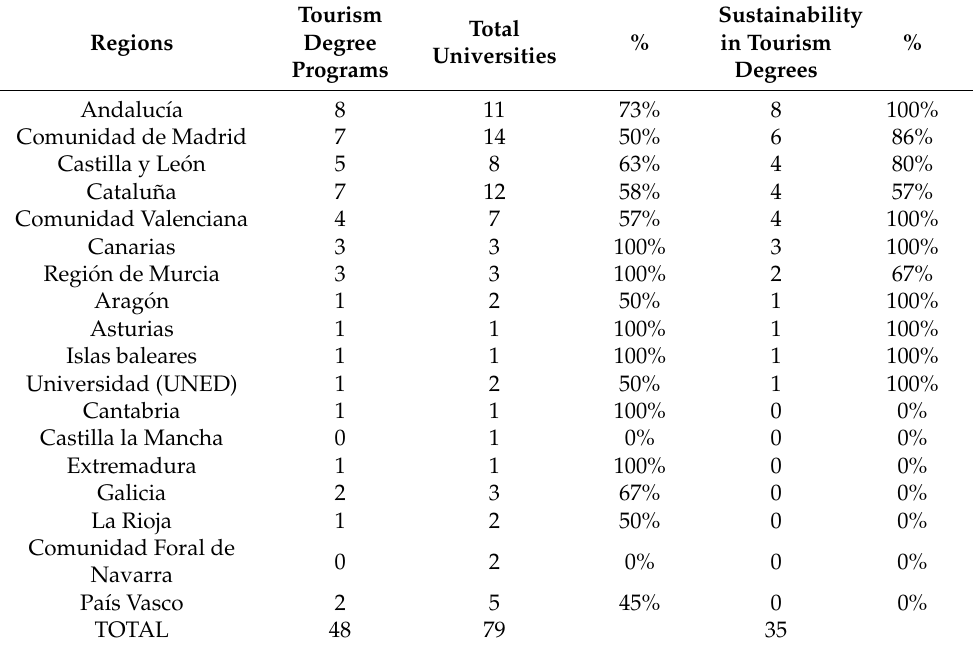
Table 2. Sustainability related subjects in Spanish Tourism degree programs per